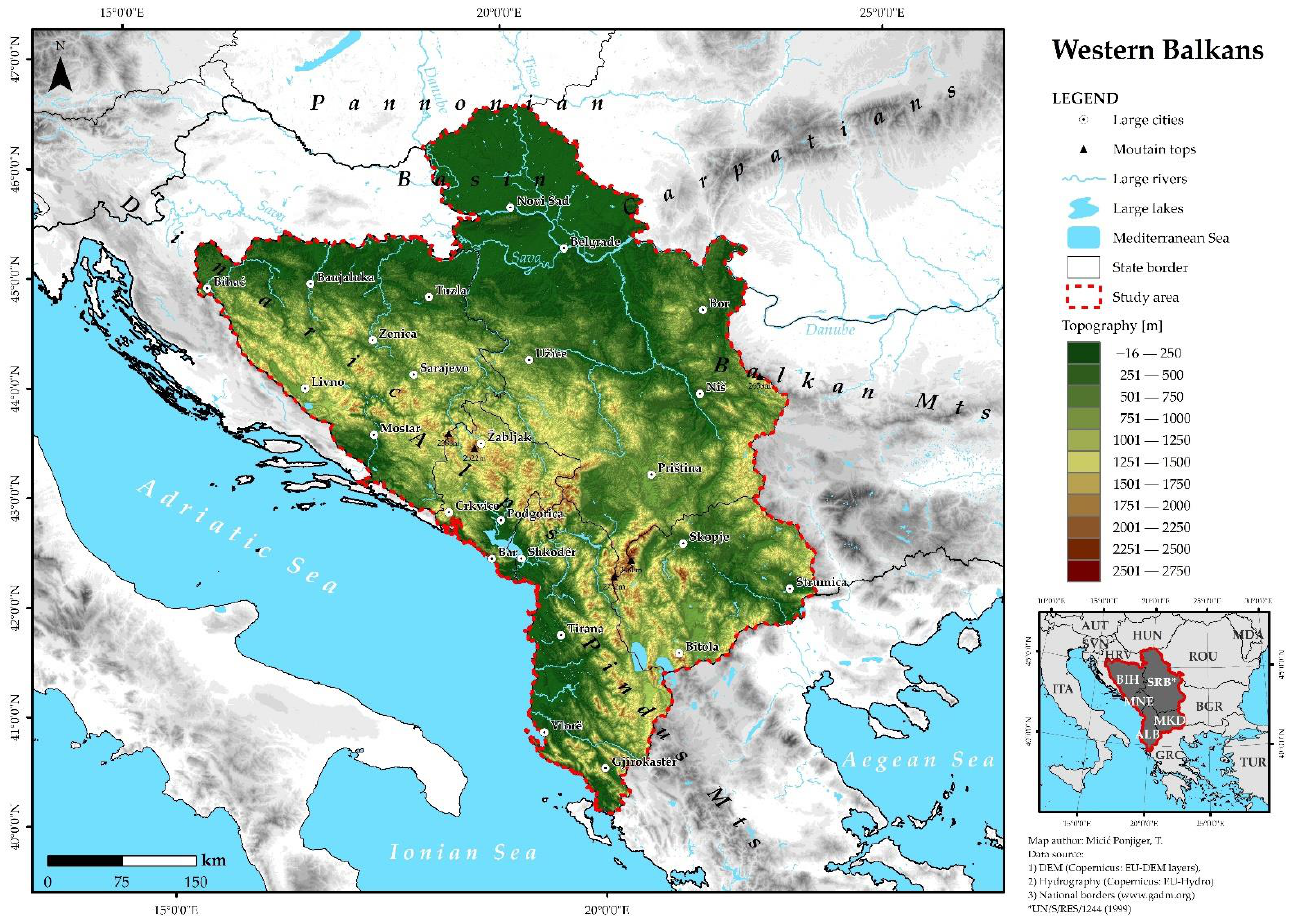
Figure 1. The WB study area and the surrounding